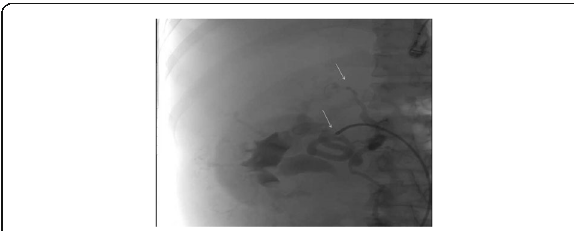
Fig. 4 Neoplastic mass treatment. Angiography shows that the neoplasm is mainly vascularized by both a large efferent branch of the renal artery (arrow) and the lower adrenal artery (arrow)